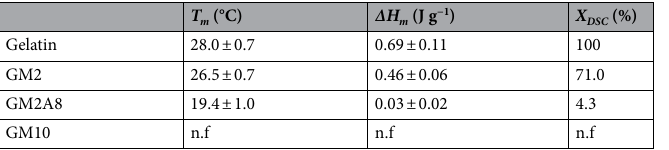
Table 1. Melting temperatures T m and melting enthalpies ΔH m obtained from the DSC curves shown in Fig. 2 as well as renaturation levels X DSC calculated from DSC measurements. GM10 did not show any signal in the DSC measurements or the signal was too shallow to be analysed, so no values were found (n.f.). The measured melting enthalpies were significantly different from each other [p < 0.05 (gelatin, GM2), p < 0.001 (gelatin, GM2A8; GM2,